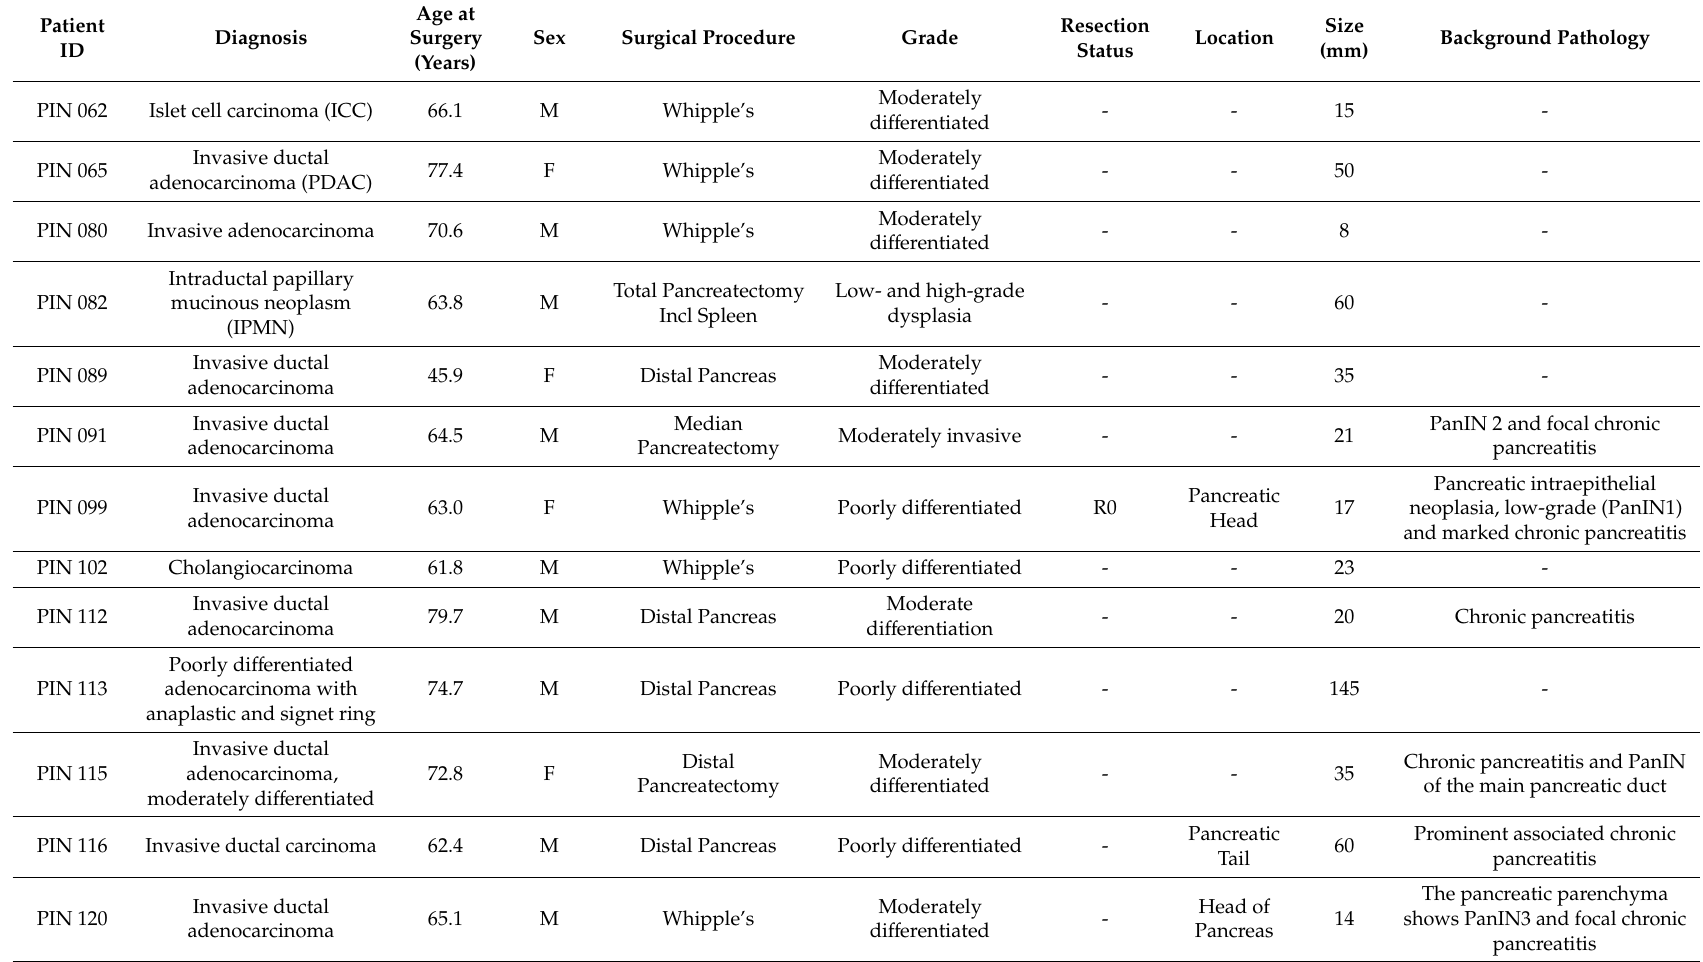
Table 1. Patient diagnostic